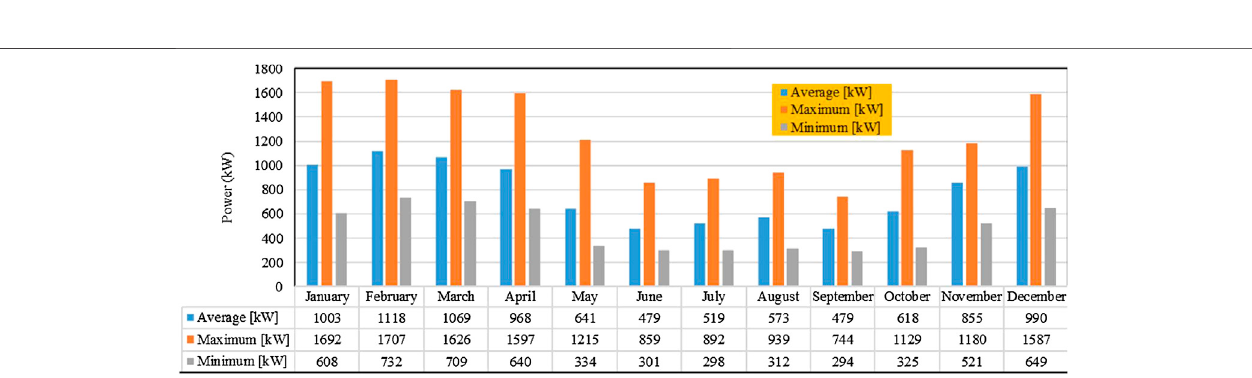
FIGURE 7 | Average, maximum and minimum power demands over a year (2016) for the island of Ushant.